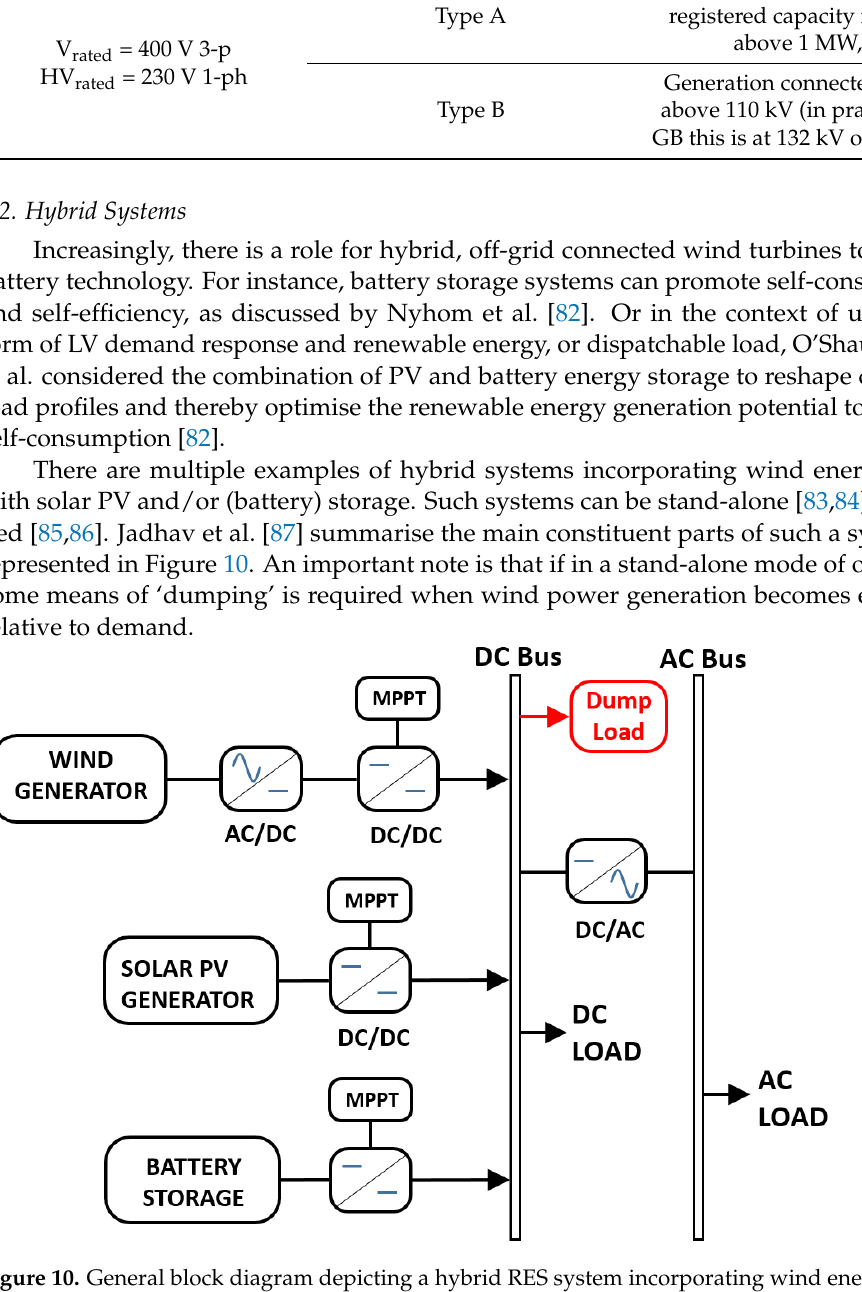
Figure 10. General block diagram depicting a hybrid RES system incorporating wind